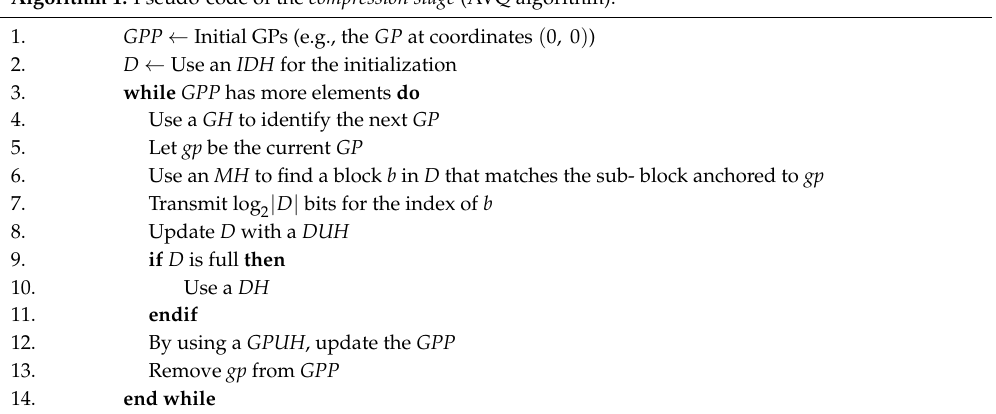
Algorithm 1. Pseudo-code of the compression stage (AVQ algorithm).